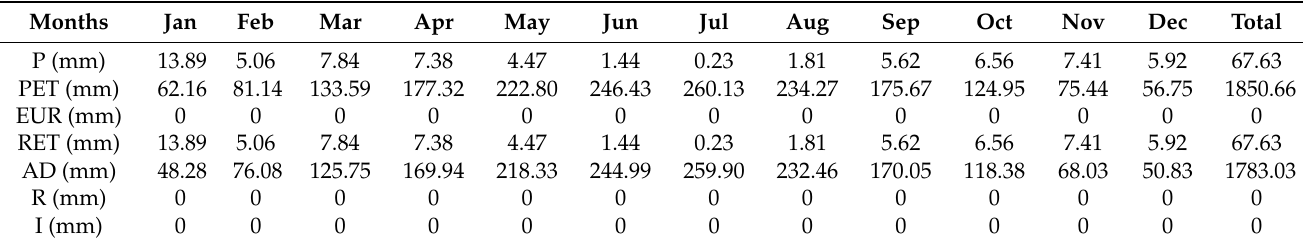
Table 1. Water balance for Guemar airport climatic station between